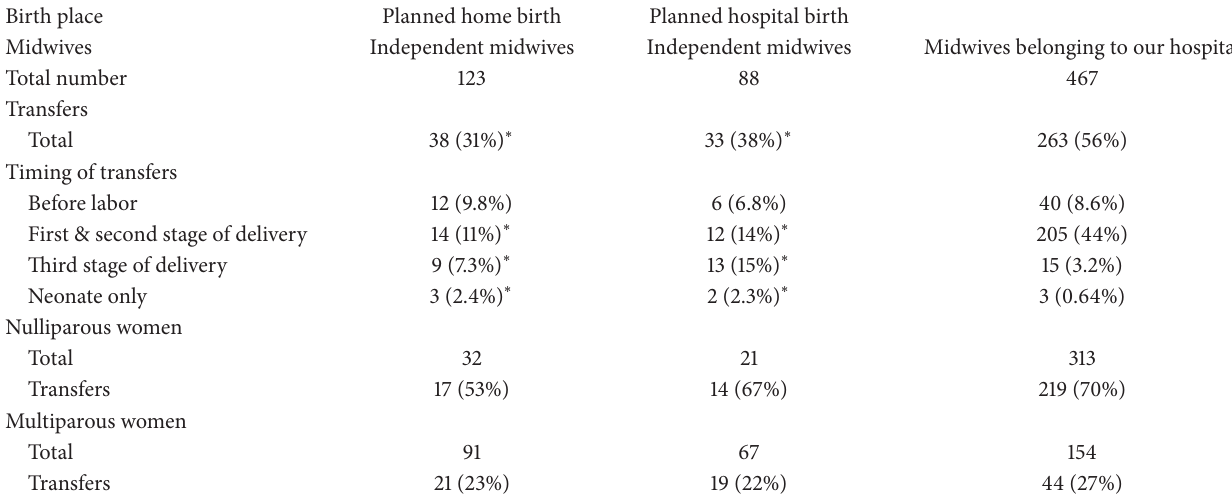
Table 2: Rate of transfers from midwife-led care to obstetric shared care in the 3 groups of the midwife-led primary delivery care systems.